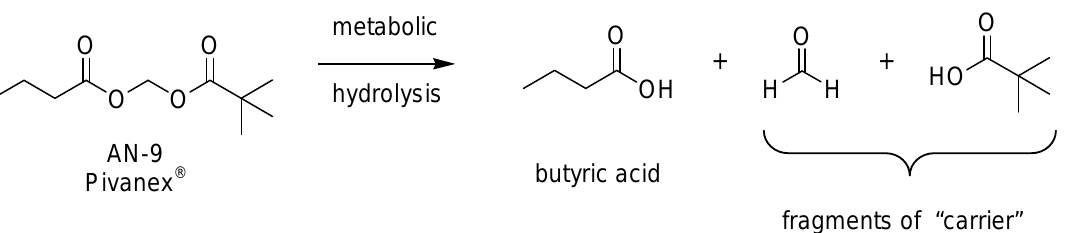
Figure 44 . Metabolic hydrolysis of Pivanex ® .